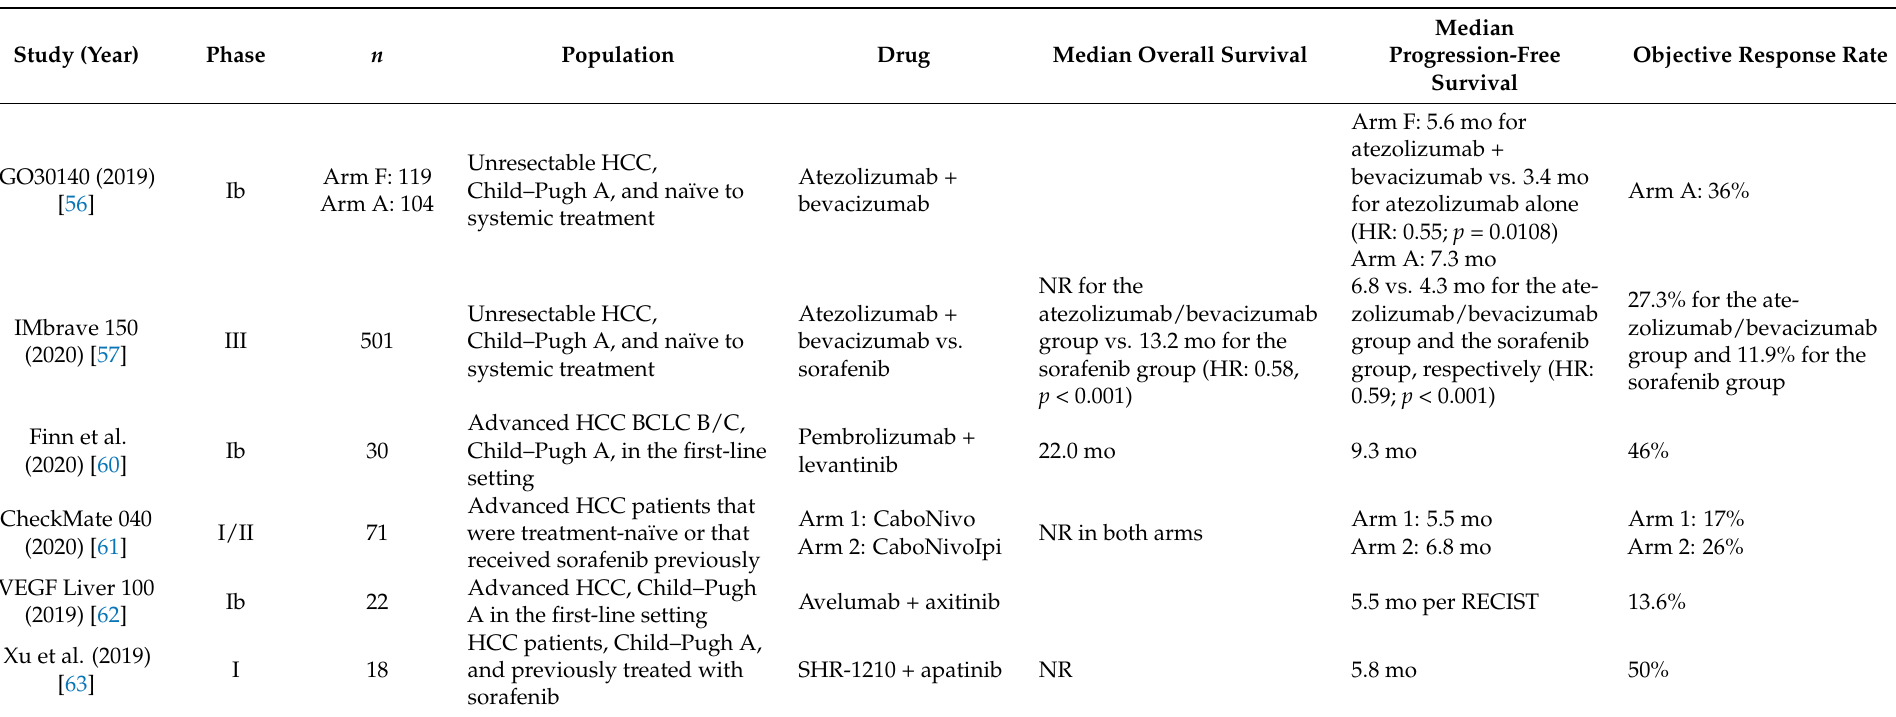
Table 3. Results of selected studies testing the combination of immune checkpoint inhibitors and targeted therapies in advanced HCC